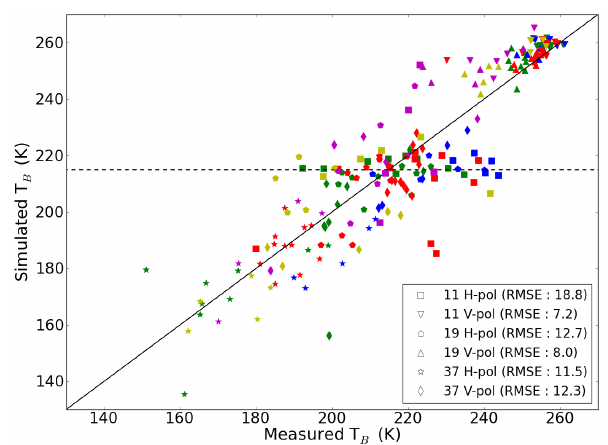
Figure 6. T B simulated with ice lenses included in DMRT-ML but without bridging. The symbol types correspond to the frequency and colors to the sites: red is JB Jan-transect ; green is JB Jan-others ; blue is JB Feb ; yellow is JB Mar ; magenta is UMI. The dotted black line represents the T B where the simulations underestimated the spatial variability at 11 and 19GHz H-pol.